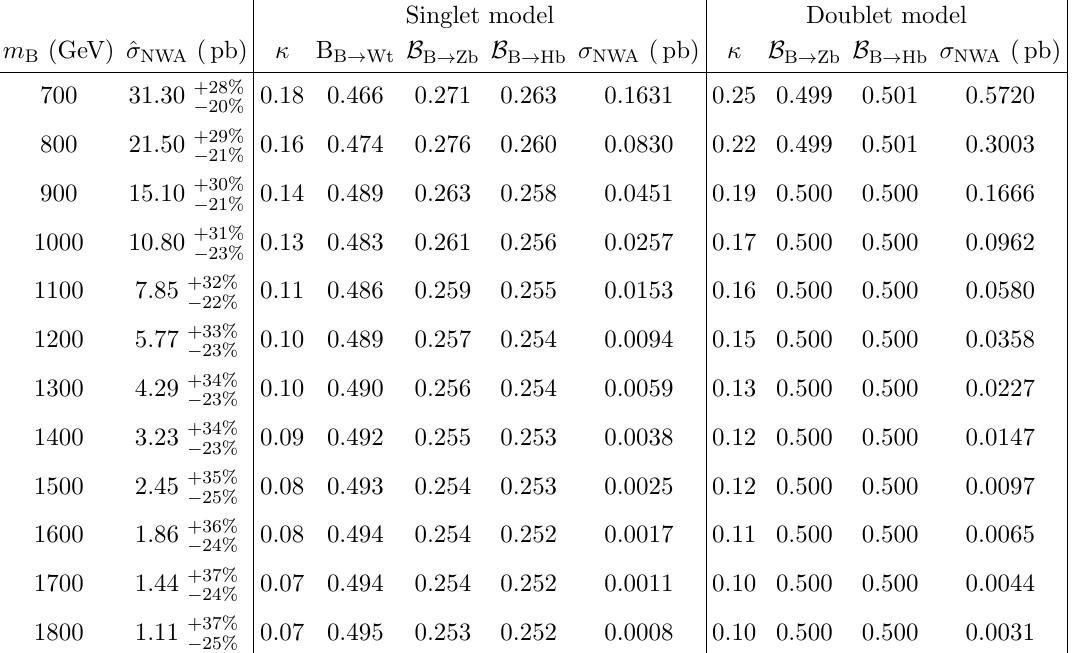
Table 1. Cross sections for pp ! Bbq, with the ratio (cid:0) B =m B (cid:12)xed to 1% (NWA). The couplings and branching fractions in simpli(cid:12)ed models are calculated using the equations in the text. The uncertainties in the production cross sections correspond to the halving and doubling of the QCD renormalization and factorization scales.